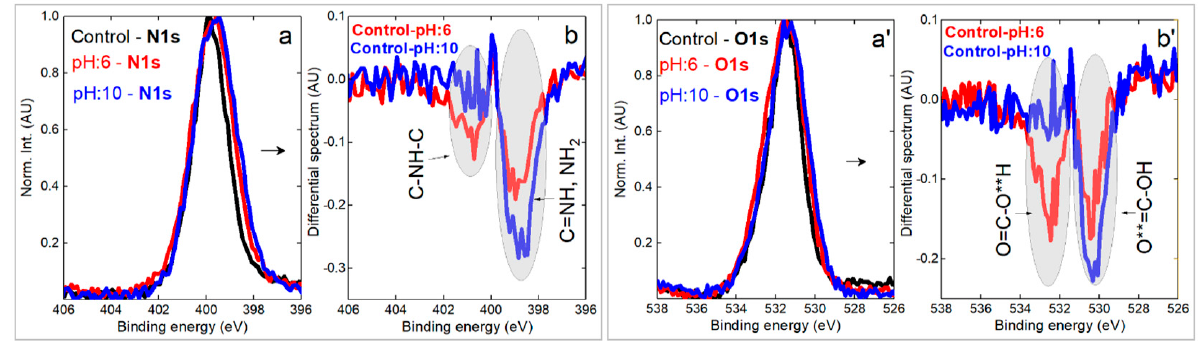
Figure 9. XPS core level N1s ( a ) and O1s ( a’ ) spectra for control silk (black), dyed silk after interaction with acidic media ‘pH:6’ (red) and after in fl uence of alkaline conditions ‘pH:10’ (blue) accompanied by corresponding residuum spectra ( b , b’ ).